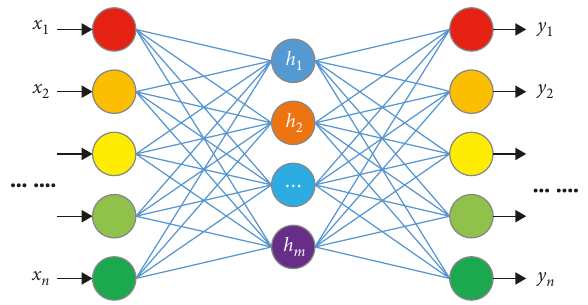
Figure 1: The architecture of